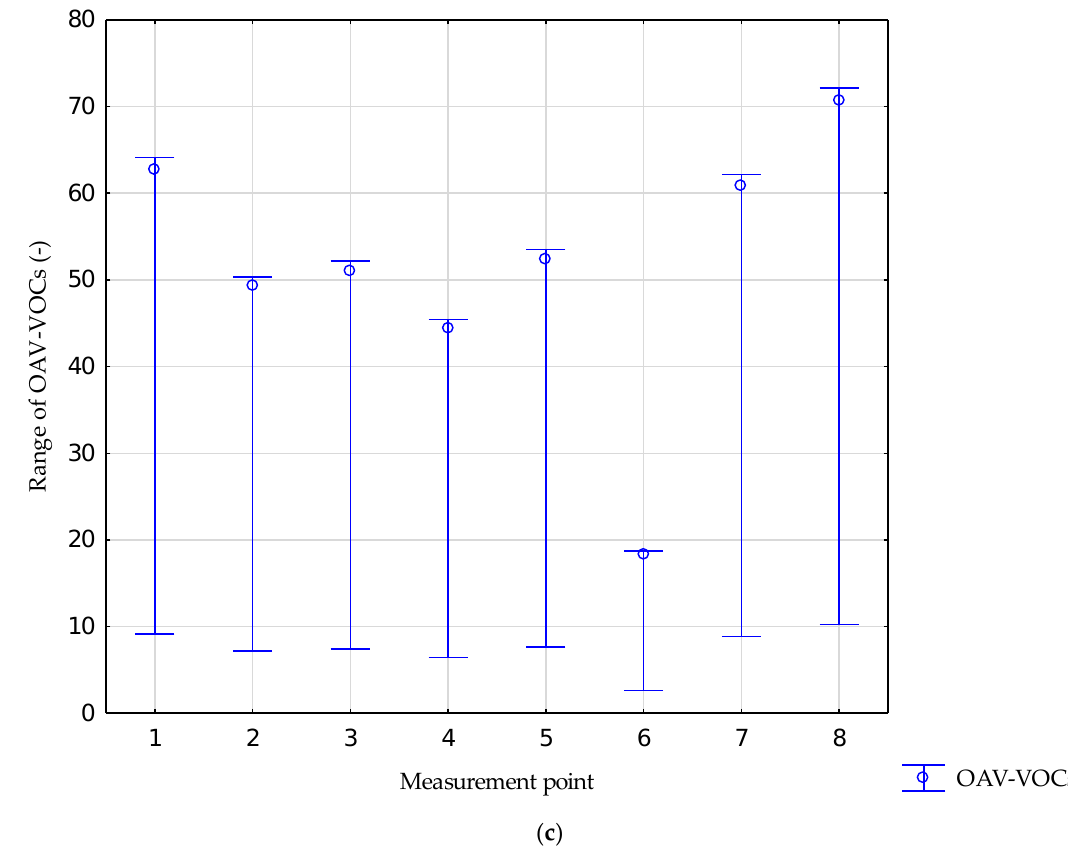
Figure 5. The results obtained at biogas plant located in Promnik. ( a ) Odorant concentrations. ( b ) Odour activity values (based on toluene) and odour concentration at individual measurement points: 1, inside the waste storage plant; 2, mixed waste storage; 3, selectively collected waste storage; 4, mechanical treatment; 5, fermentation preparation; 6, oxygen stabilization; 7, technological wastewater pumping station; and 8, digestate dewatering. ( c ) Range of odour activity values (based on toluene, styrene, and